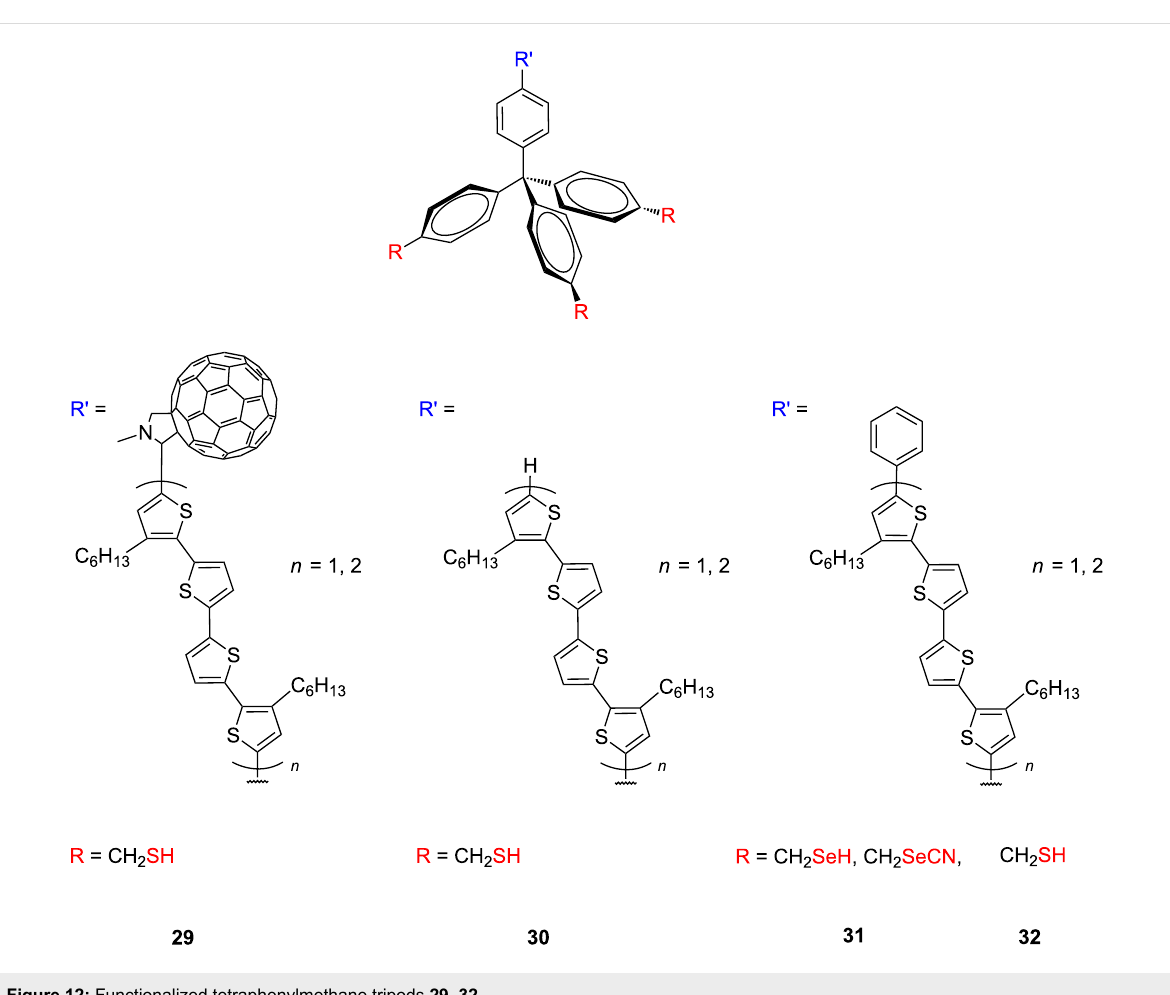
hanced charge transport through the SAM. They